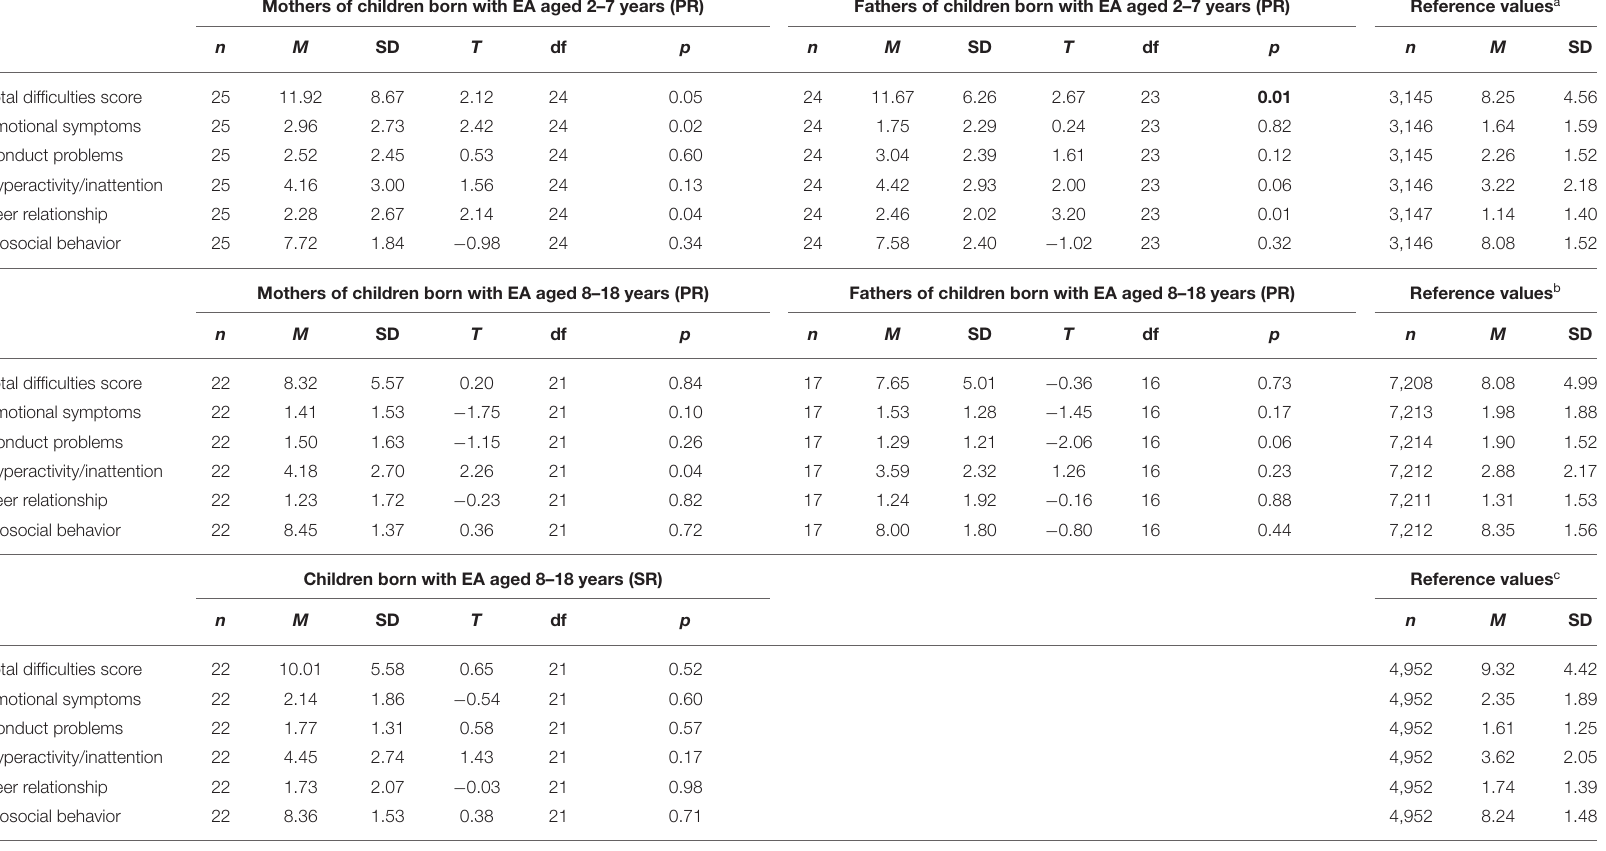
TABLE 4 | Comparison of SDQ-values for EA patients with Germen reference values. Mothers of children born with EA aged 2–7 years (PR) Fathers of children born with EA aged 2–7 years